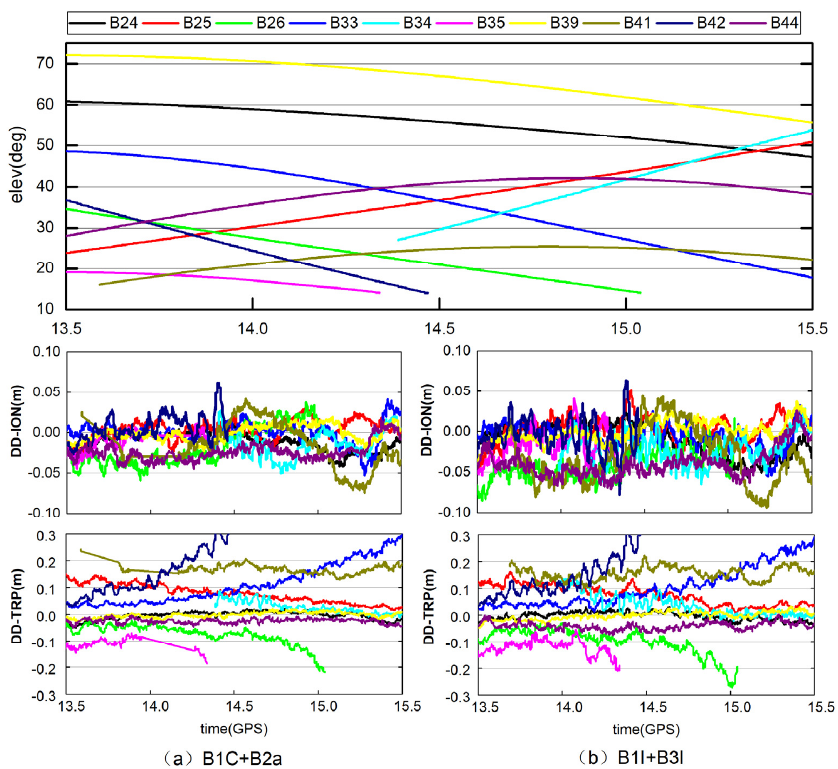
Figure 4. ( a ) Double-difference atmospheric correction for B1C+B2a combination of BDS-3 in WH04- HG02. ( b ) Double-difference atmospheric correction for B1I+B3I combination of BDS-3 in WH04- HG02.